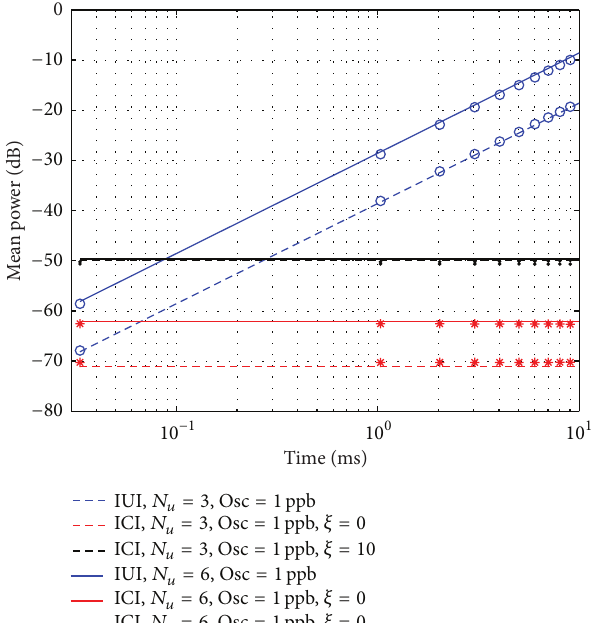
Figure 2: Mean power of interuser and intercarrier interferences in a Rayleigh fading channel. Here, 7 base stations serve 3 and 6 users, respectively. Analytical results are shown by lines, while markers show numerical evaluations.